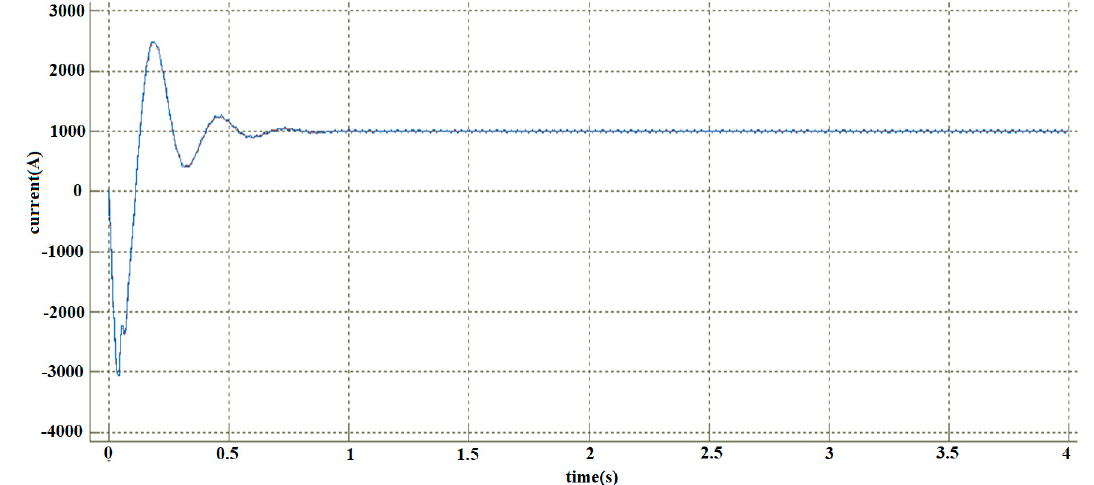
Figure 17. Output-side d axis current.